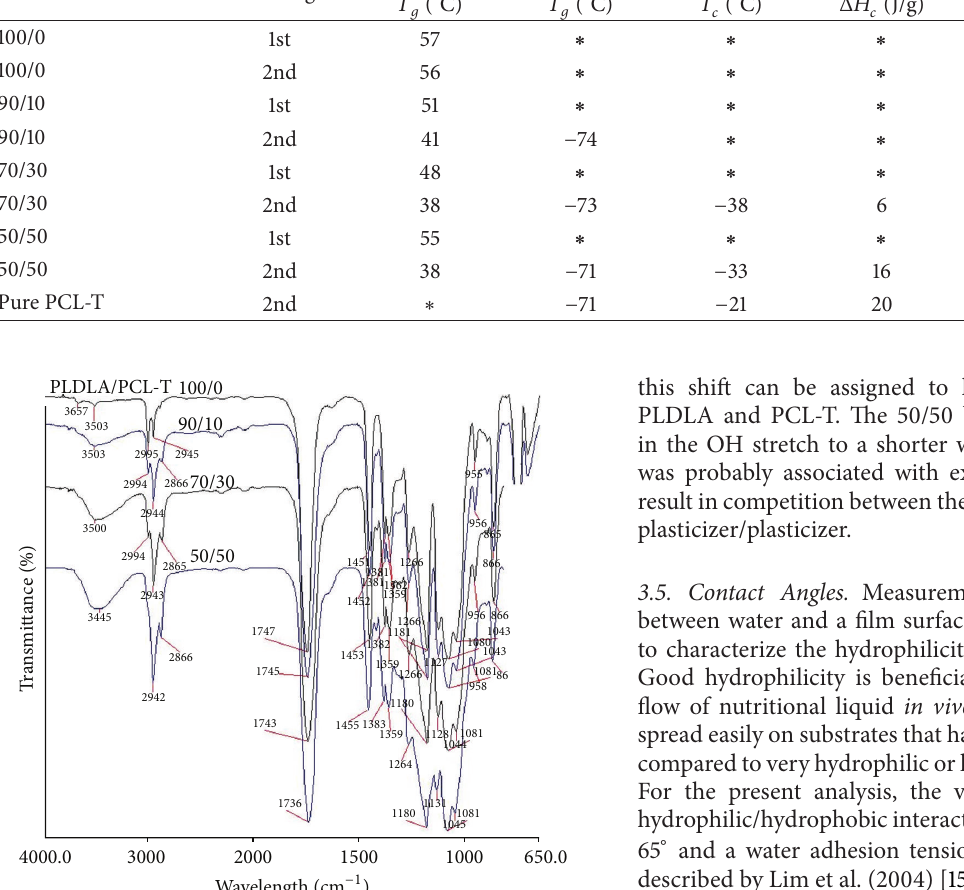
Table 3: DSC data for PLDLA/PCL-T membranes. The vitreous transition temperature ( 𝑇 𝑔 ), crystallization temperature ( 𝑇 𝑐 ), enthalpy of crystallization ( Δ𝐻 𝑐 ), fusion temperature ( 𝑇 𝑓 ), and enthalpy of fusion ( Δ𝐻 𝑓 ) were obtained for the first and second heating. PLDLA/PCL-T blend